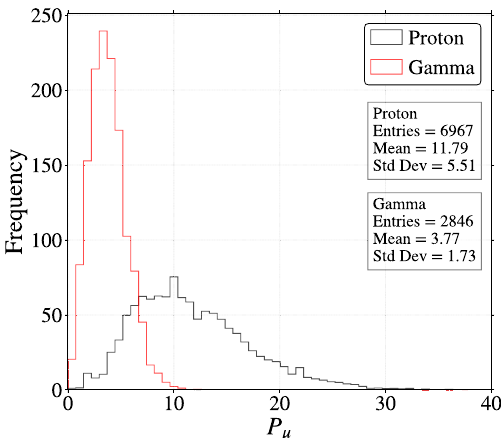
Fig. 4 Impact of electromagnetic contamination using the normalised inverse cumulative function for the probability P proton-induced events with E 0 ∈ [4 , 6] TeV and θ 0 ∈ [5 ◦ ; 15 ◦ ]